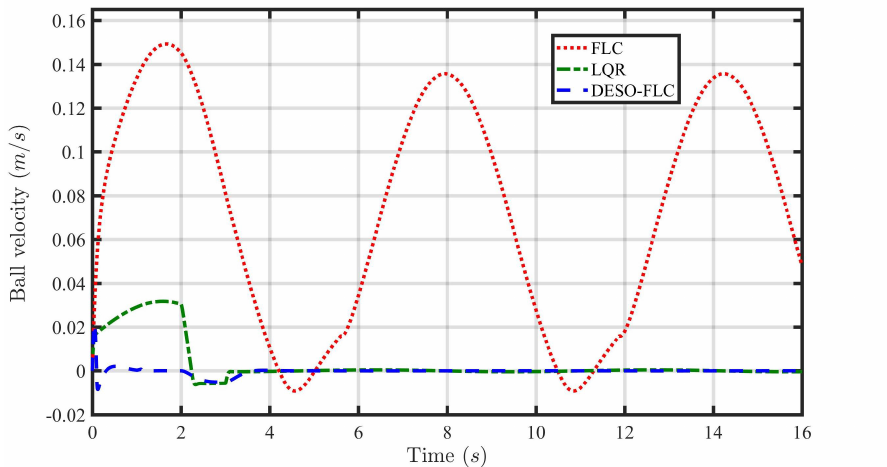
Figure 4. Response of steel ball velocity ( x 2 ) in the presence of the payload disturbance ( d ( t ) ).